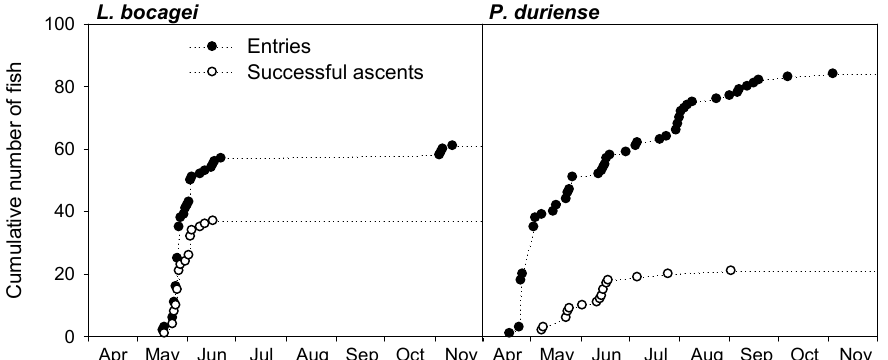
Figure 2. Cumulative number of different fish entering the fish ladder and successful ascents. First record for entries and last record for successful ascents were plotted.